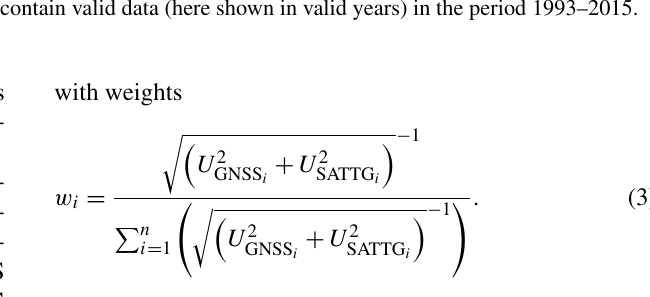
Figure 3. (a) Global distribution of 52 common GESLA, PSMSL and ULR6 GNSS stations, which meet the described requirements. (b) Number of TG stations sorted by the number of months which contain valid data (here shown in valid years) in the period 1993–2015.